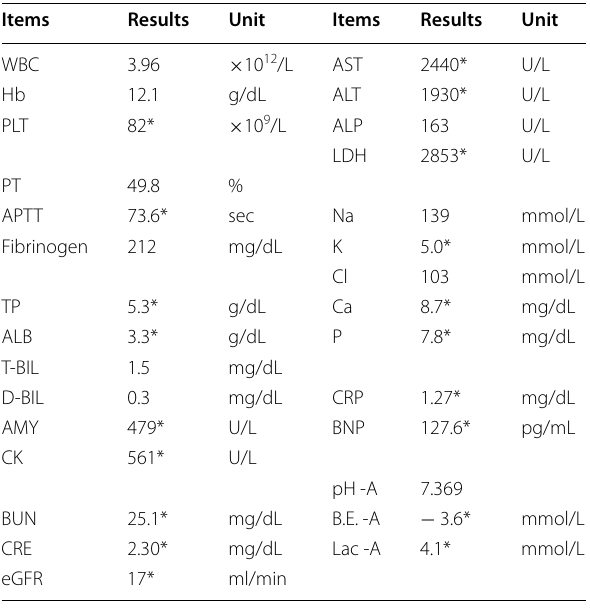
Table 1 Preoperative hematological examination